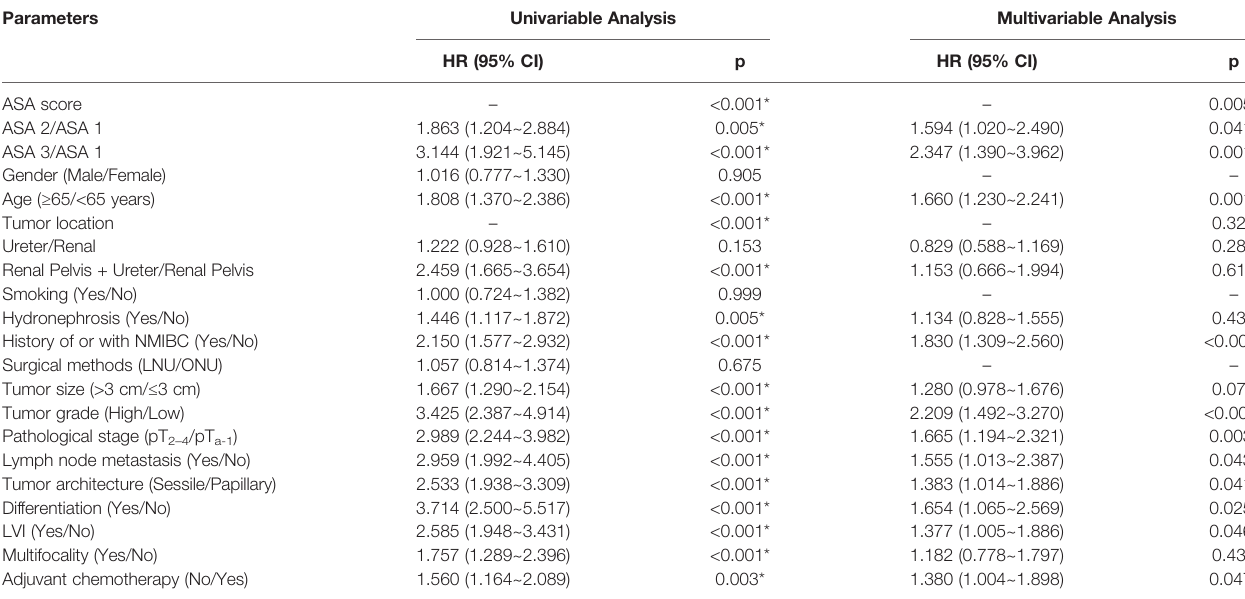
TABLE 4 | Univariable and multivariable Cox regression models to predict CSS.